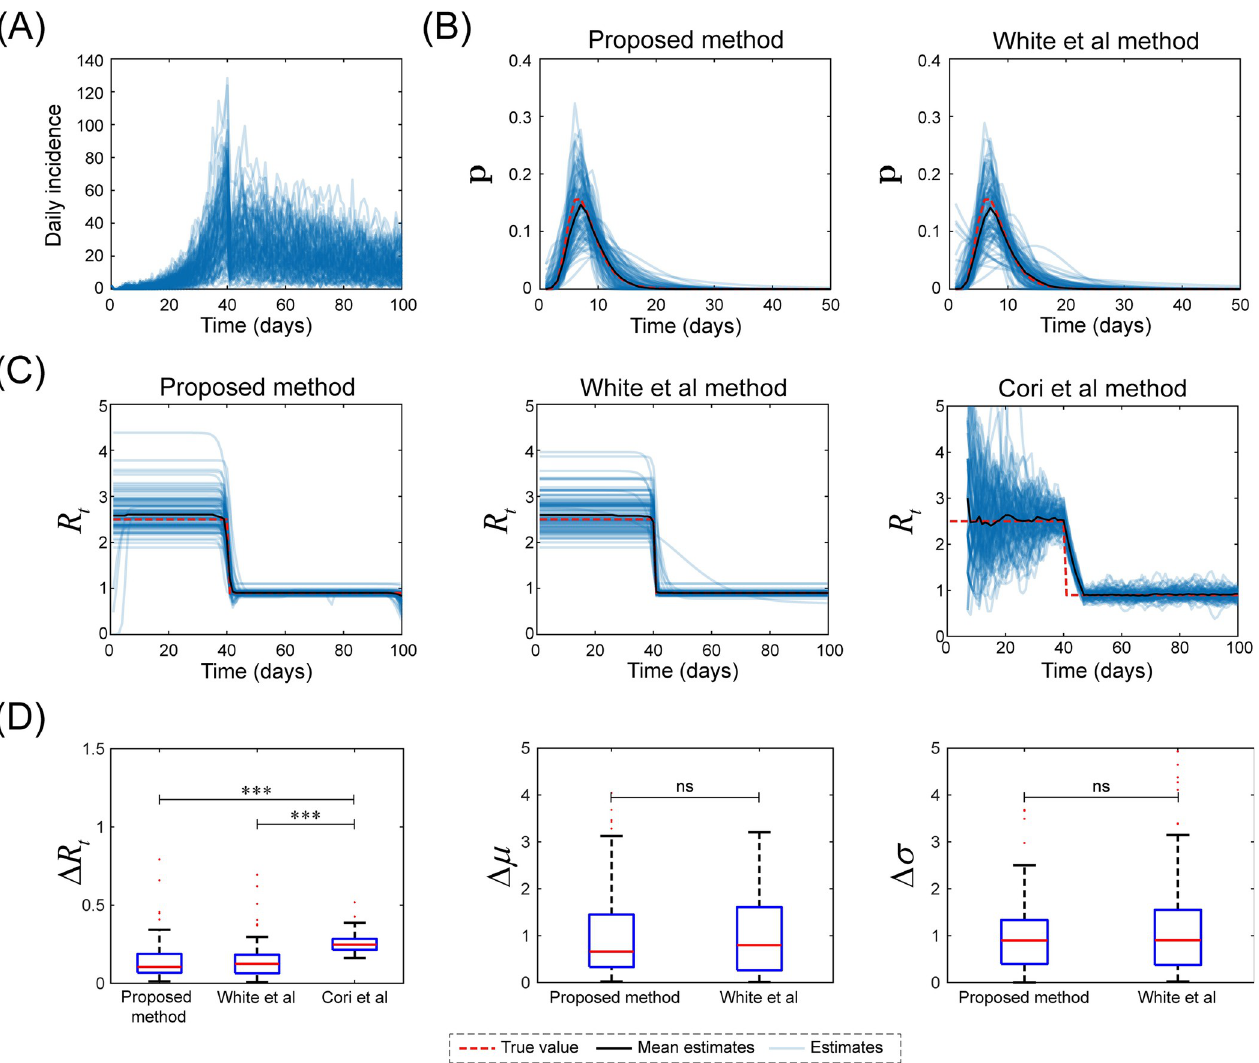
Fig 4. Comparison of methods in scenario one. Daily incidence (A) was obtained based on the assumptions that the number of initial cases was 2, the serial interval exhibited a lognormal distribution with a mean and variance of 8 and 9, respectively, and a constant R before ( R 1 = 2.5) and after ( R 2 = 0.9) a control measure on day 40. The results of serial interval obtained by our method and White et al method (B). The results of instantaneous reproductive number obtained by all methods (C). The red dashed lines show the ground truth. Δ R , Δ μ , and Δ σ (D). The blue lines show the estimates, and the dark lines denote the t mean values for 100 simulations. ns: no significant difference, *** : P <